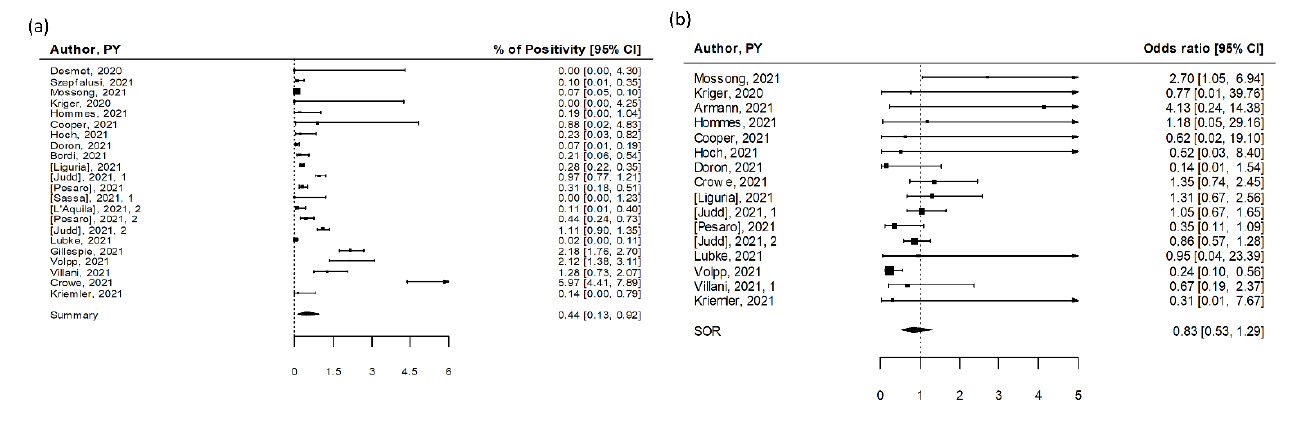
Figure 2. Pooled estimates for SARS-CoV-2 screening studies [13–33]. ( a ) Pooled estimate of testing positive for SARS-CoV-2. ( b ) Summary odds ratio of testing positive for SARS-CoV-2 for children versus adults linked to educational settings. Table 1. Summary estimates.